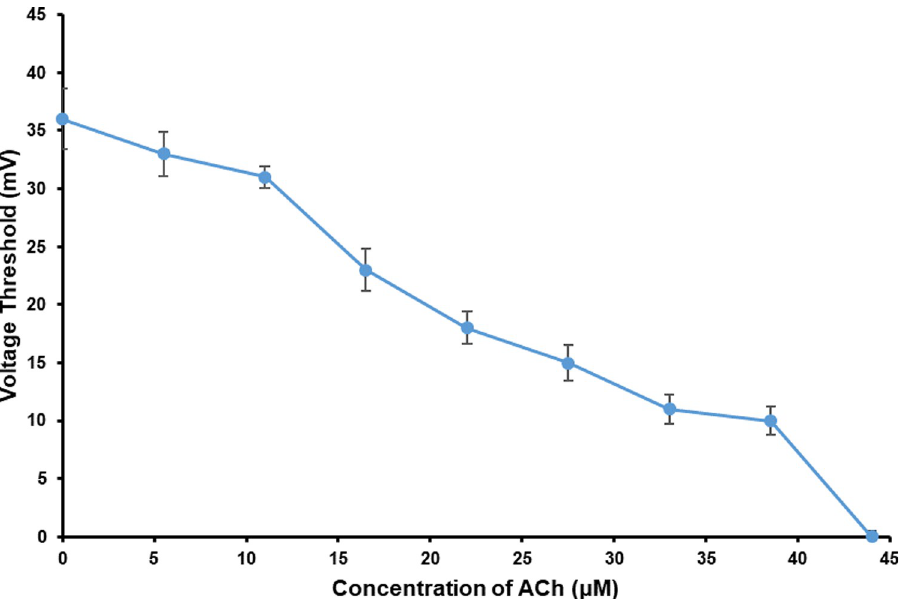
Fig 3. The V Th of PC12 quasi-neuronal networks under the effect of ACh in different concentrations ( n = 5).